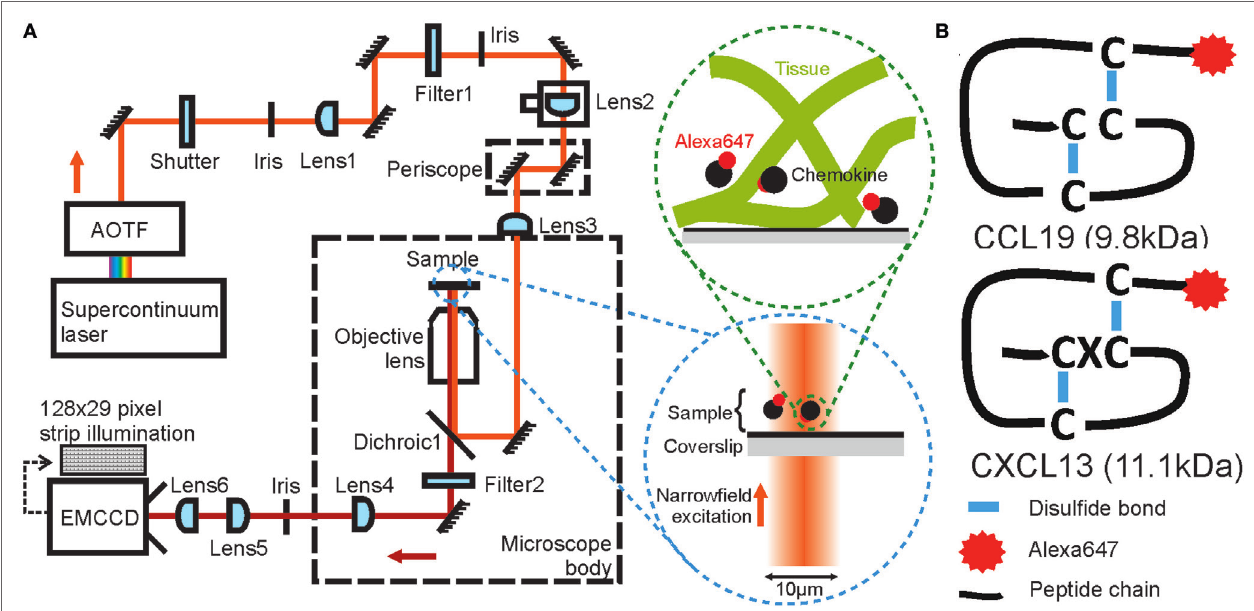
FigUre 1 | Schematic diagrams of high-speed narrowfield microscopy and the experimental system. (a) The imaging framework showing the bespoke fluorescence microscope and diagrams of image acquisition. (B) The structure of Alexa Fluor 647 labeled CCL19 and